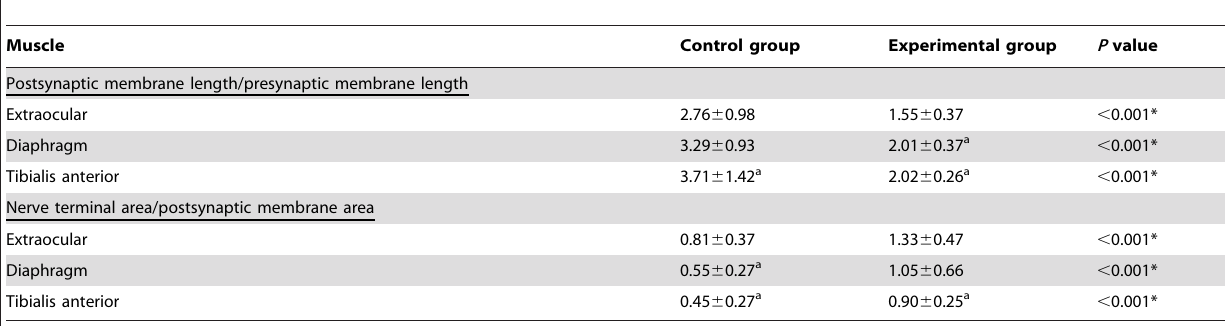
Table 2. Comparison of post- and presynaptic membrane ratios between the two groups.